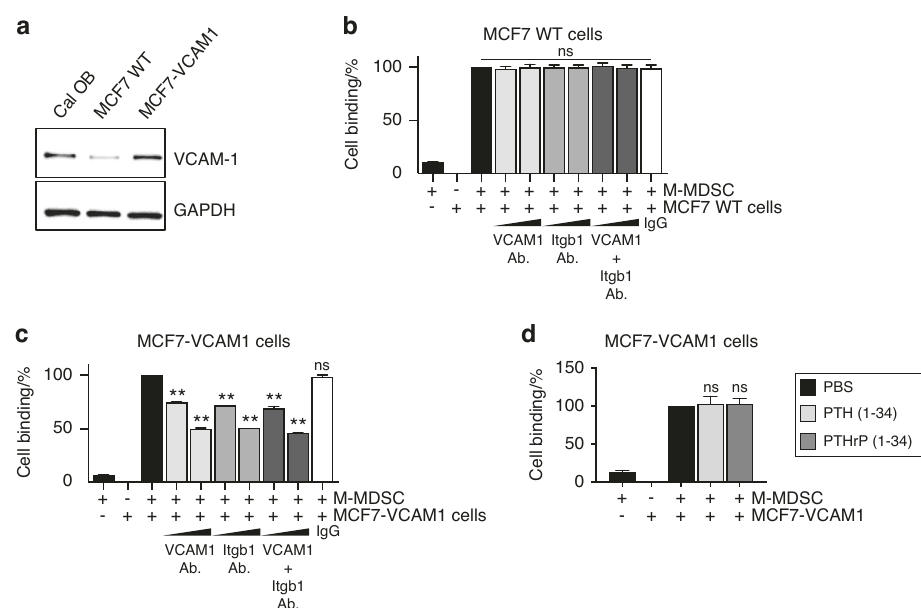
Fig. 6 Ectopic expression of VCAM1 confers M-MDSC binding capability. a Western blotting showing VCAM1 ectopic overexpression in MCF7 breast cancer cells. b , c In vitro cell binding assay showing that anti-VCAM1 and/or anti-integrin β 1 antibodies (1 μ g or 2 μ g) block M-MDSC binding to VCAM1-overexpressing ( c ) but not parental wild-type ( b ) MCF7 cells. Data are the mean ± SEM ( n = 3 per group). ** P < 0.01, one- way ANOVA with multiple group comparisons. NS nonsigni fi cant. d In vitro cell binding assay showing that ectopic expression of VCAM1 in MCF-7 cells confers M-MDSC binding capacity, and the binding is reversed by rhPTH (1-34, 10 nmol·L − 1 ) or rhPTHrP (1-34, 10 nmol·L − 1 ). Data are the mean ± SEM ( n = 3 per group). One-way ANOVA with multiple group comparisons. NS nonsigni fi